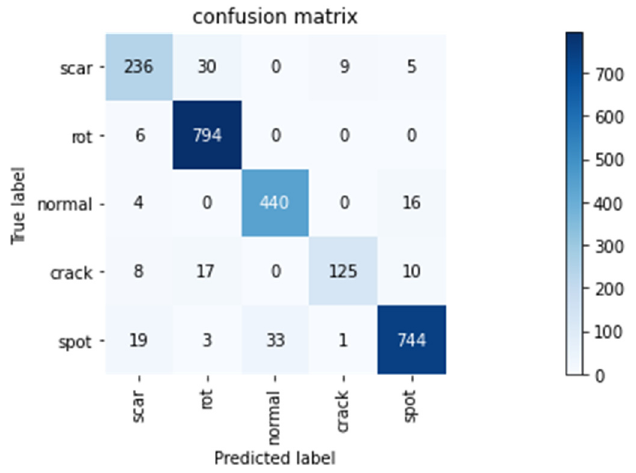
Figure 5. Confusion matrix diagram of green plum defect detection network test.